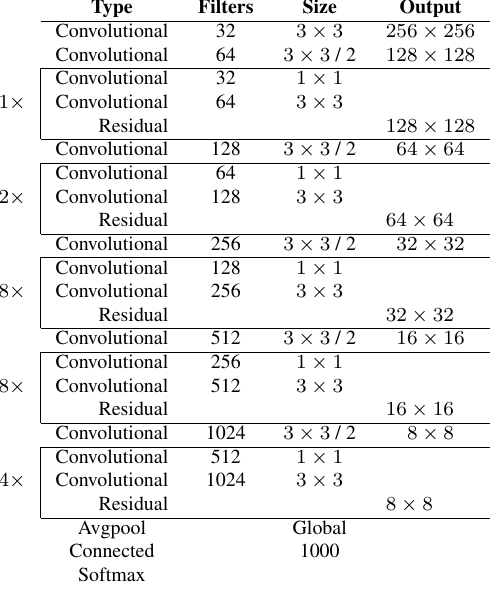
Table 1. The YOLO-HUD